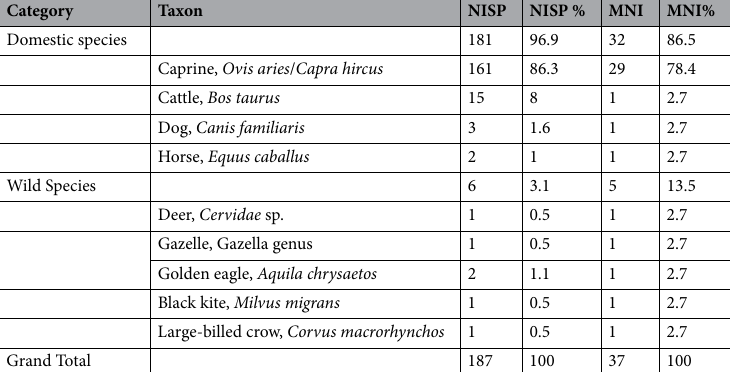
Table 1. NISP and MNI for the assemblage in F2, Shirenzigou.